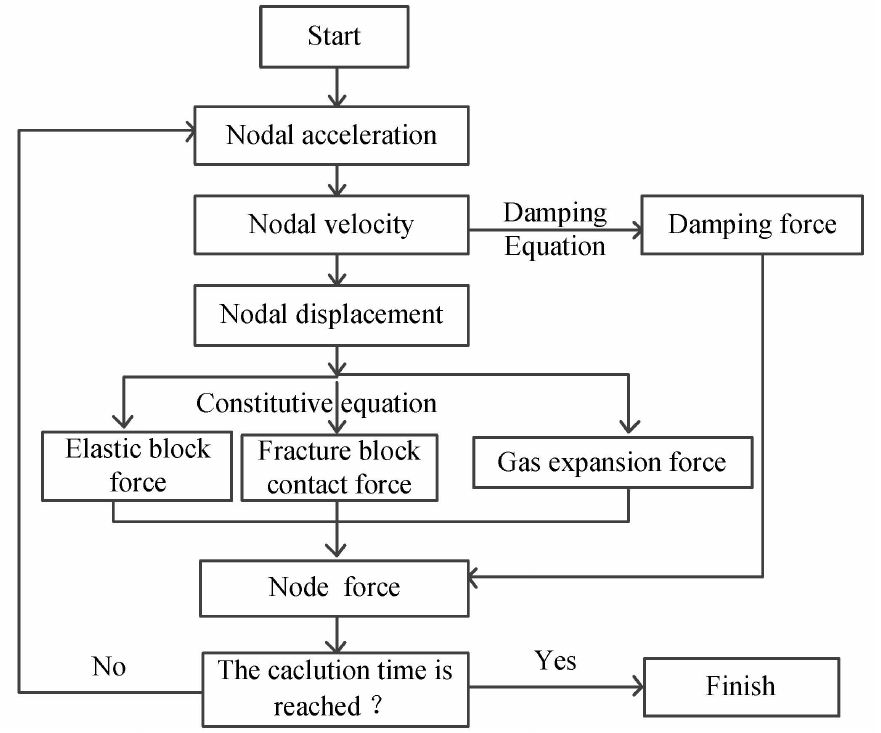
Figure 1. The simulation procedure diagram of coal and gas